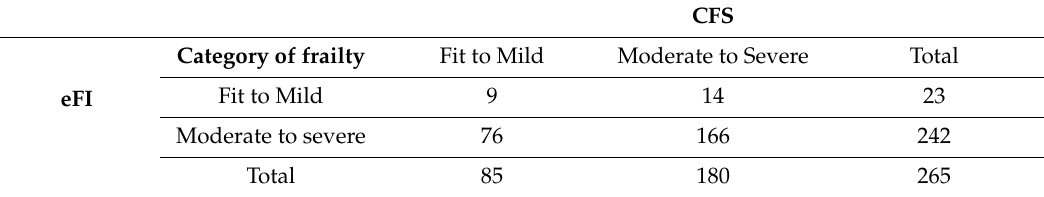
Table 2. Association between the electronic Frailty Index (eFI) and the Clinical Frailty Scale